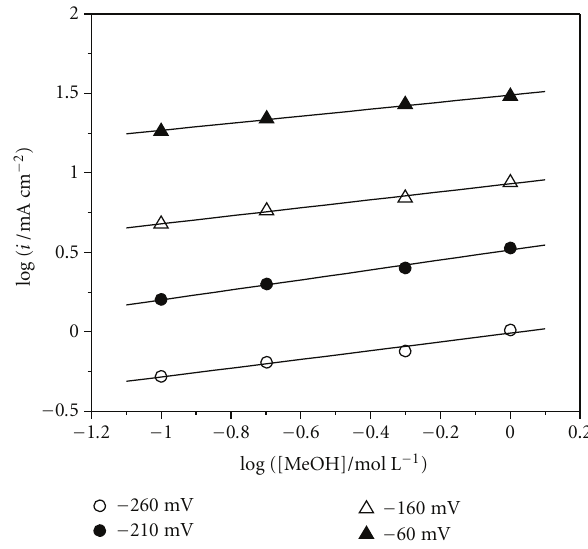
Figure 7: Dependence of methanol oxidation rate on methanol concentration in 0.5 MNaOH solution on Pt-Pd/C catalyst at dif- ferent potentials.